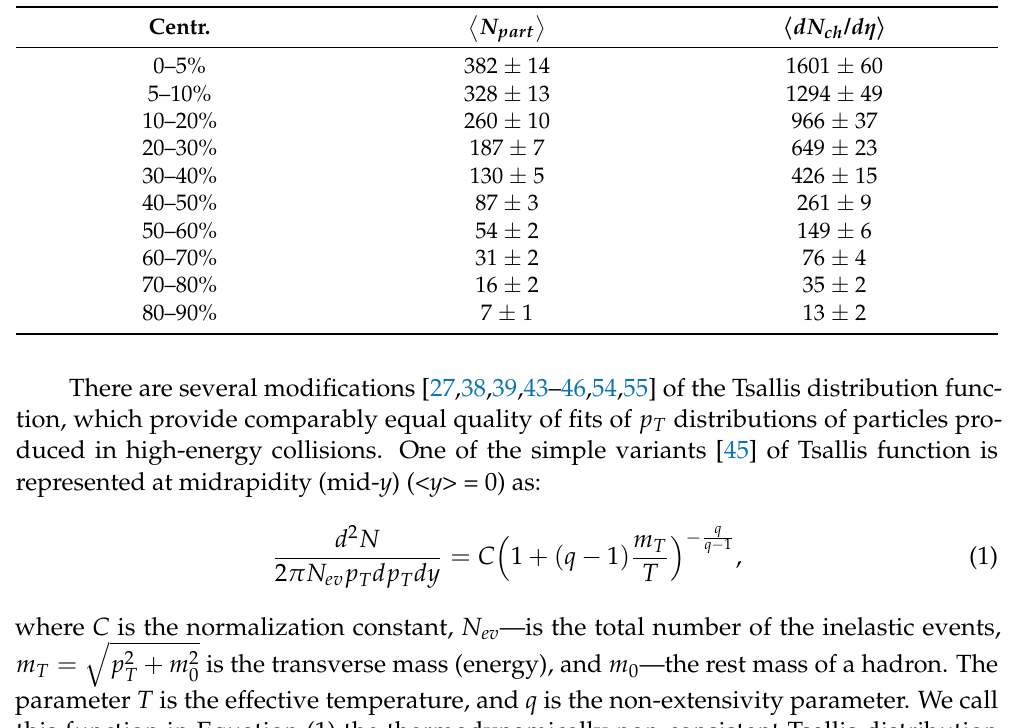
Table 1. The average number of participant nucleons and mean charged-particle multiplicity densities [16,53] in the analyzed groups of centralities of Pb + Pb collisions at